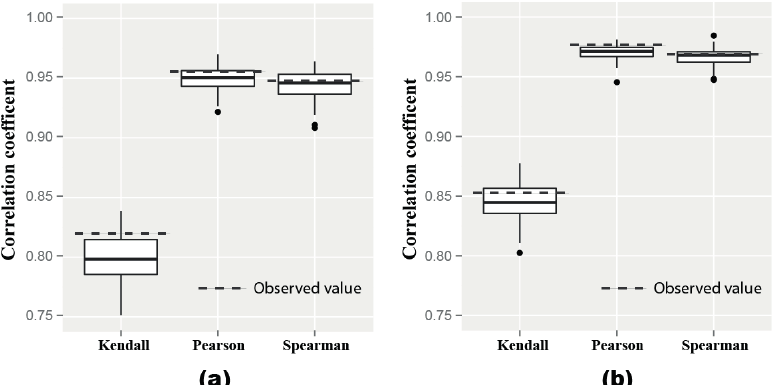
Fig. 4 Correlation coefficients of the observed and all generated data: (a) S1-S2; and (b)